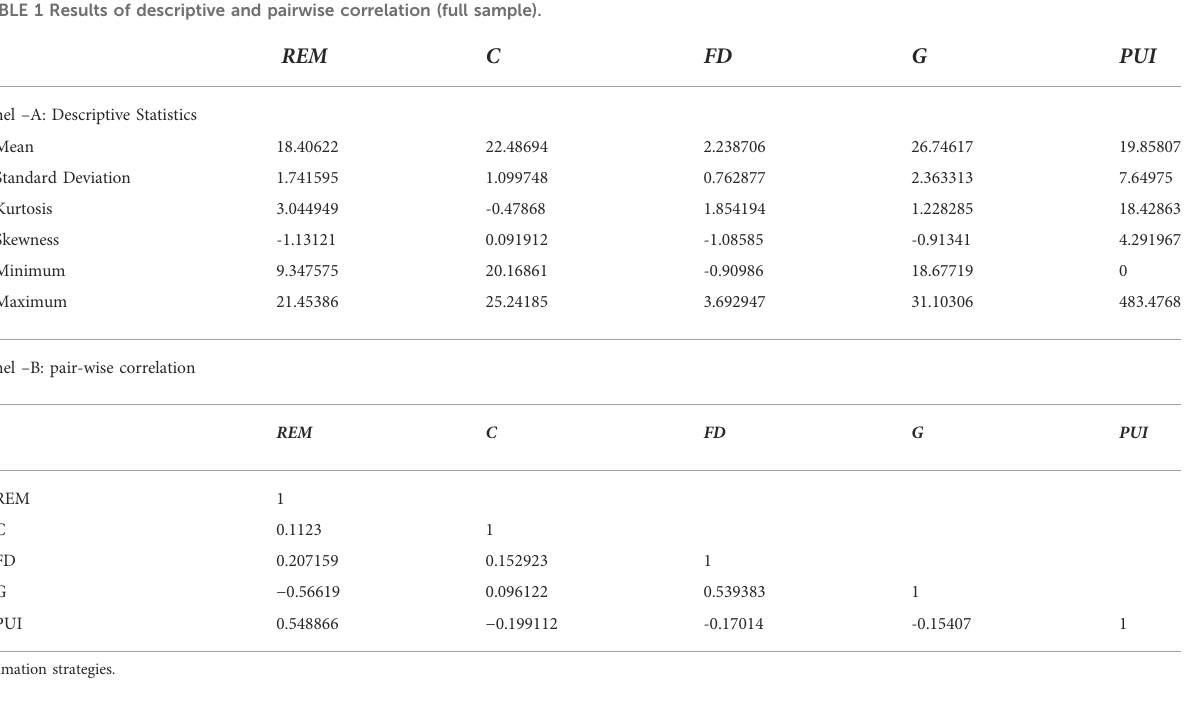
TABLE 2 Cross-sectional dependency